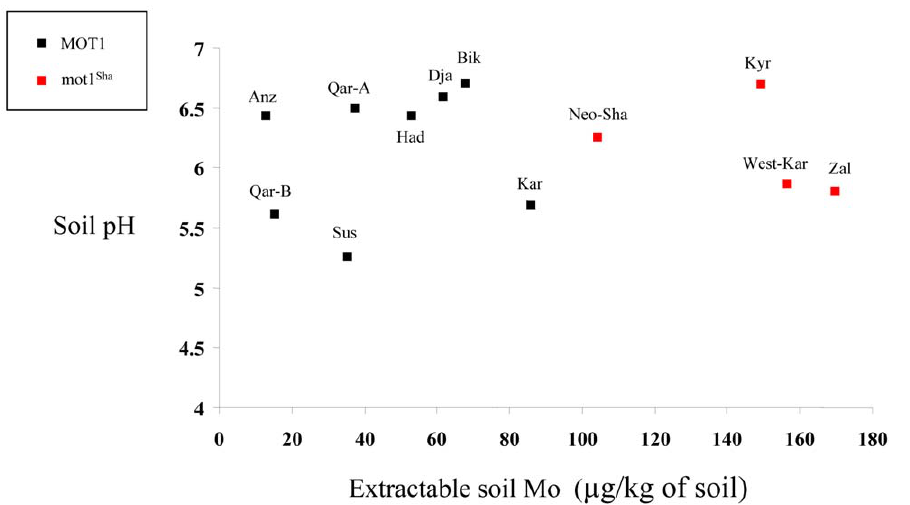
Figure 4. West-Asian populations highlight the correlation between MOT1 Sha allele and high native soil Mo content. Soil parameters (pH, extractable Mo) from the precise original collection site are represented for independent populations carrying (red dots) or not (black dots) the MOT1 Sha allele. Figure S3 MOT1 transcript accumulation does not explain MOT1 Sha defective allele. MOT1 transcript accumulation relative to GAPDH and PP2A controls is shown from roots of diverse genotypes as in Figure 3. Contrary to L er and mot1.1 , Shahdara accumulates normal levels of transcript. Standard errors are shown. Figure S4 MOT1 Sha is able to transport Mo in yeast. The Sha allele of MOT1 was overexpressed in yeast heterologous system (Sha/p416) and shown to lead to Mo accumulation compared to the empty vector (p416, used as reference) or the yeast wild-type strain (BY4741), to an extent not significantly different from the Col MOT1 allele (Col/p416). Error bars represent interquantile range of medians. Figure S5 Multiple accessions sharing the MOT1 Sha haplotype confirm the causative gene and polymorphism. Peatmoss pheno- type of diverse genotypes is shown: 5 independent Sha-like accessions (Stw-0, Kly-2, Sij-4, Kondara and Zal-3) and F1 plants from complementation crosses between each of these accessions and either the mot1.1 mutant or its wild-type genetic background (Col-0). As in Figure 2, all accessions sharing the MOT1 Sha haplotype are both sensitive and unable to rescue the mutant phenotype. Figure S6 Worldwide distribution of functionally contrasted alleles at MOT1 . Original collection site and functional MOT1 haplotype (Sha-like in red dots, L er -like in yellow, Col-like in blue) is shown on a world map for the 102 accessions sequenced in Table S1. L er -like accessions are found across the whole species known distribution range, while Sha-like accessions are restricted to Asia and Russia (‘West-Asia’). Figure S7 Effect of Mo toxicity on fitness components -seed number and weight- of contrasted MOT1 genotypes. The fitness consequences of Mo toxicity was tested on regular (non-acidic) soil mix with different nutrient solutions containing either traces of Mo